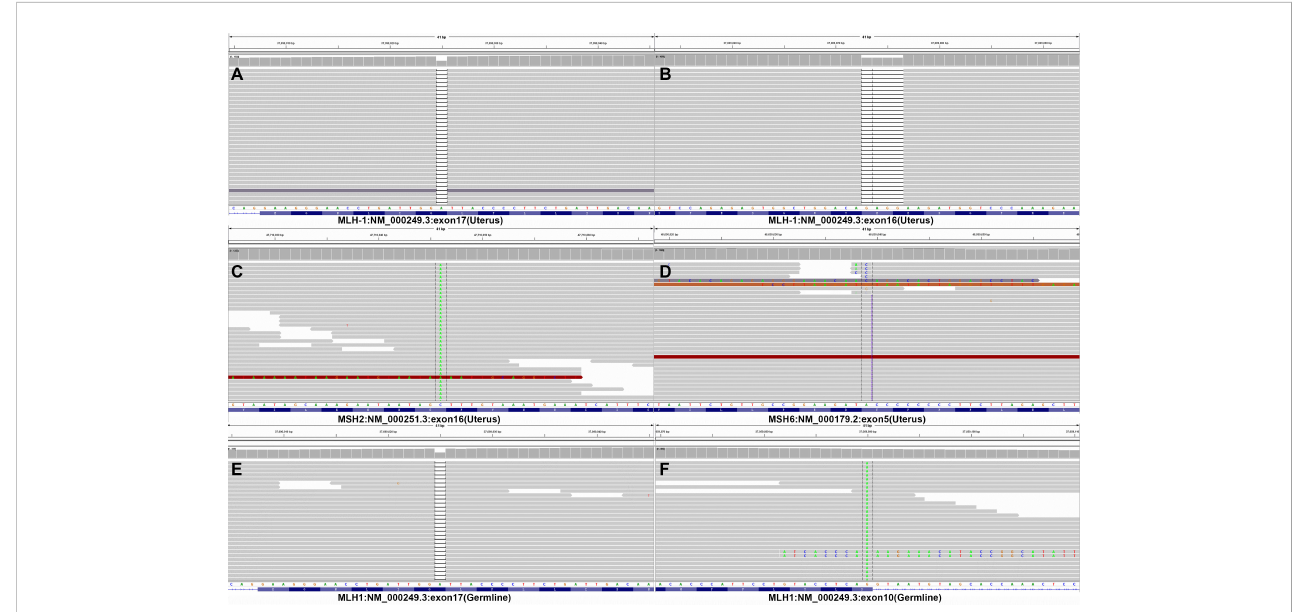
FIGURE 4 Gene analysis of endometrial and colon carcinomas. (A-D) The outcomes of DNA mismatch repair gene analysis in endometrial adenocarcinoma tissue. (E-F) The outcomes of DNA mismatch repair gene analysis in colon adenocarcinoma tissue. Endometrial adenocarcinoma tissue genetic testing revealed deletion mutations of exons 16 and 17, replacement mutations of exon 16 in MSH2, and duplication mutation of exon 5 in MSH6. Exon 10 and 17 mutations in MLH1 were also discovered during genetic testing of the colon adenocarcinoma